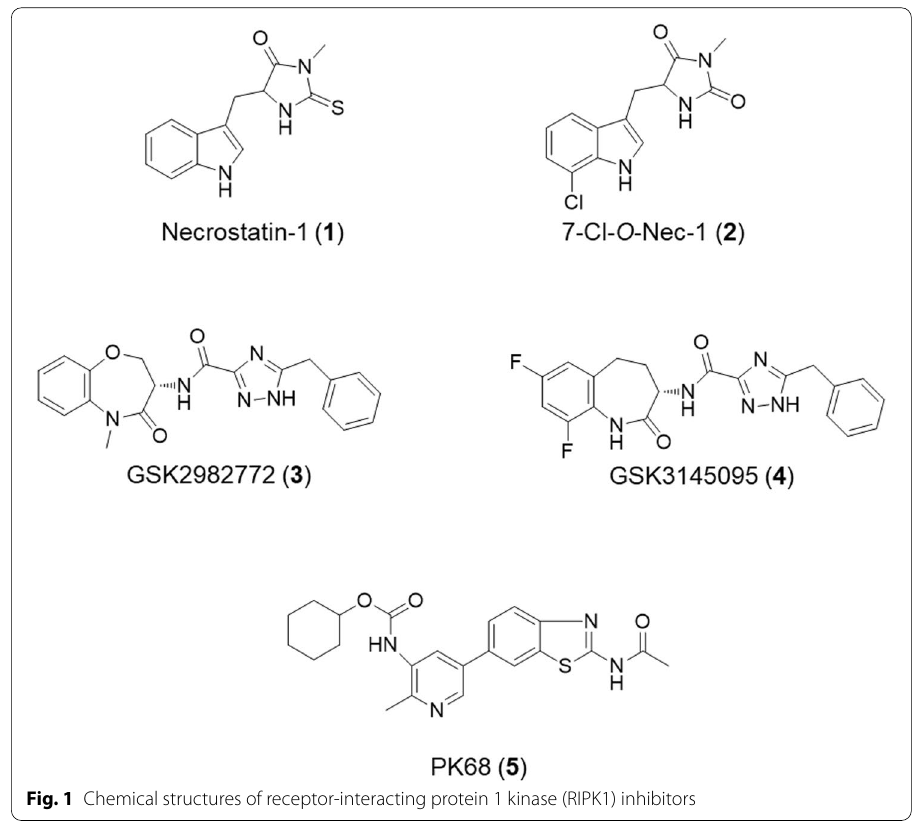
Fig. 1 Chemical structures of receptor‑interacting protein 1 kinase (RIPK1) inhibitors